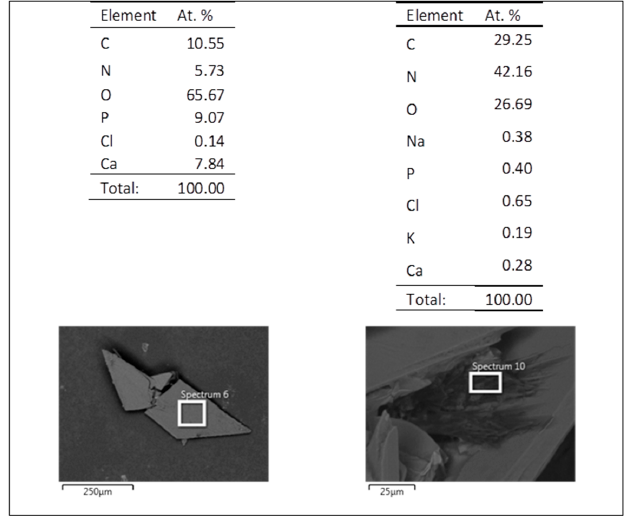
Figure 16. Chemical composition of three different precipitates formed at the surface of PP support after immersion in artificial urine for 21 days.